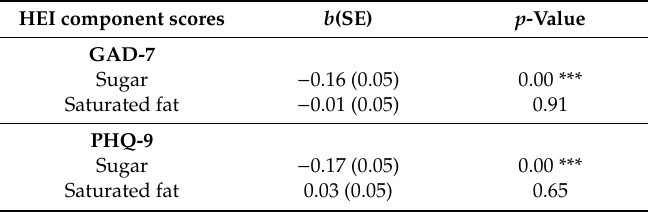
Table 4. E ff ects of anxiety on Heathy Eating Index (HEI) component scores for sugar and saturated fat and depression on HEI component scores for sugar and saturated fat (Hypotheses 3a,b).